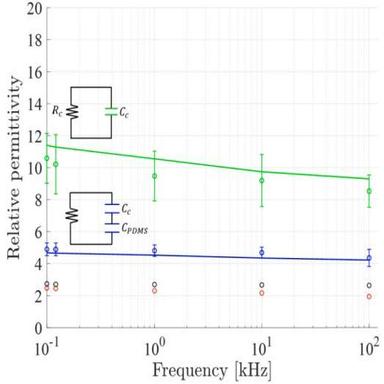
Relative permittivity of the nanofibers mat alone (red), of the pure PDMS (black), of the nanofibers integrated in PDMS with an excess of PDMS (blue), and of the nanofibers integrated in PDMS (green) at different frequencies. The continuous lines correspond to the model results.